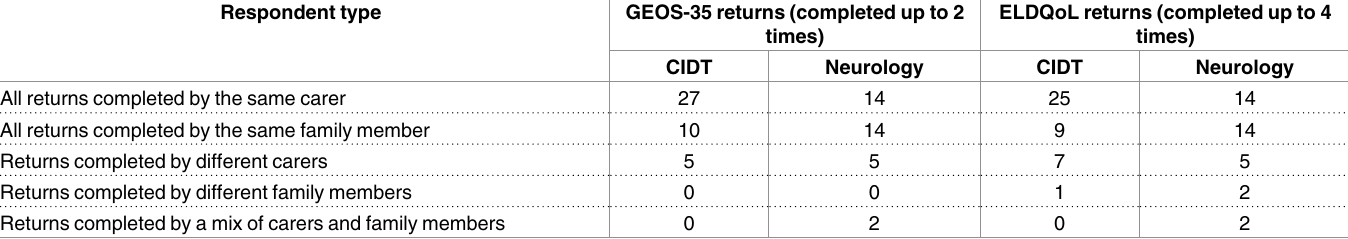
Table 3. Details of who completed the GEOS-35 and ELDQoL measures,from which the scalesused to compare the clinical servicesin Table 4 are